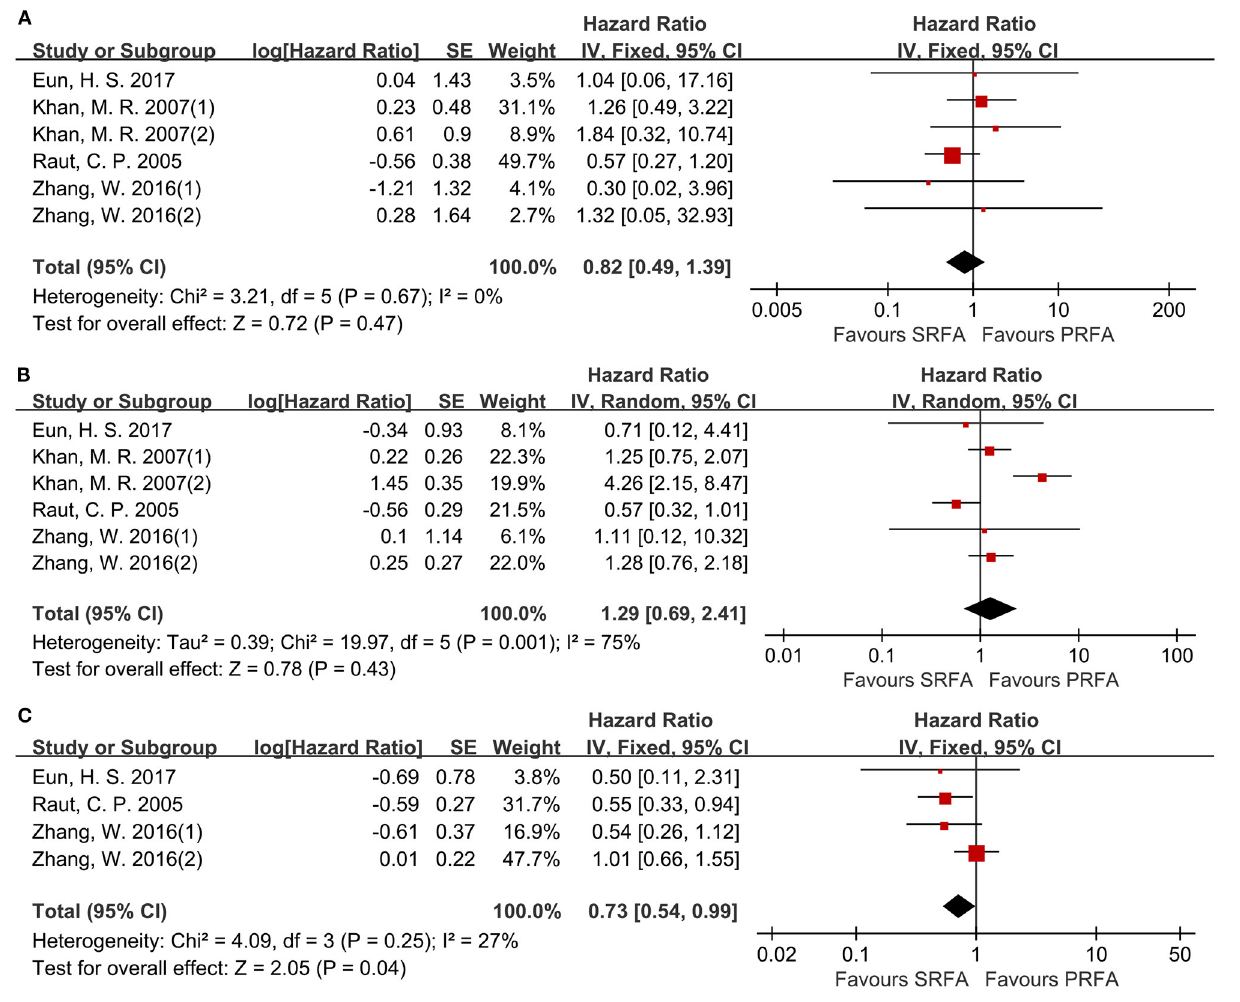
FIGURE 7 | Forest plot for DFS. (A) Forest plot for 1-year DFS indicates no significantly between the PRFA group and the SRFA group (HR, 0.82; 95% CI: 0.49–1.39). (B) Forest plot for 3-year DFS indicates no significantly between the PRFA group and the SRFA group (HR, 1.29; 95% CI: 0.69–2.41). (C) Forest plot for 5-year DFS indicates the PRFA group was significantly lower than the SRFA group (HR, 0.73; 95% CI: